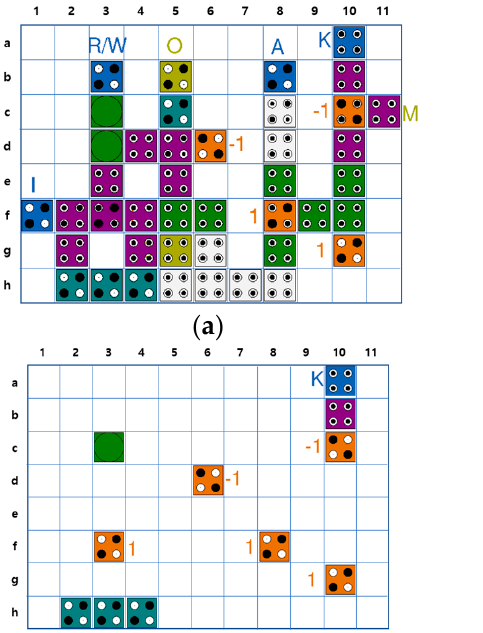
Figure 10. Logic diagram of XNOR-based CAM cell.